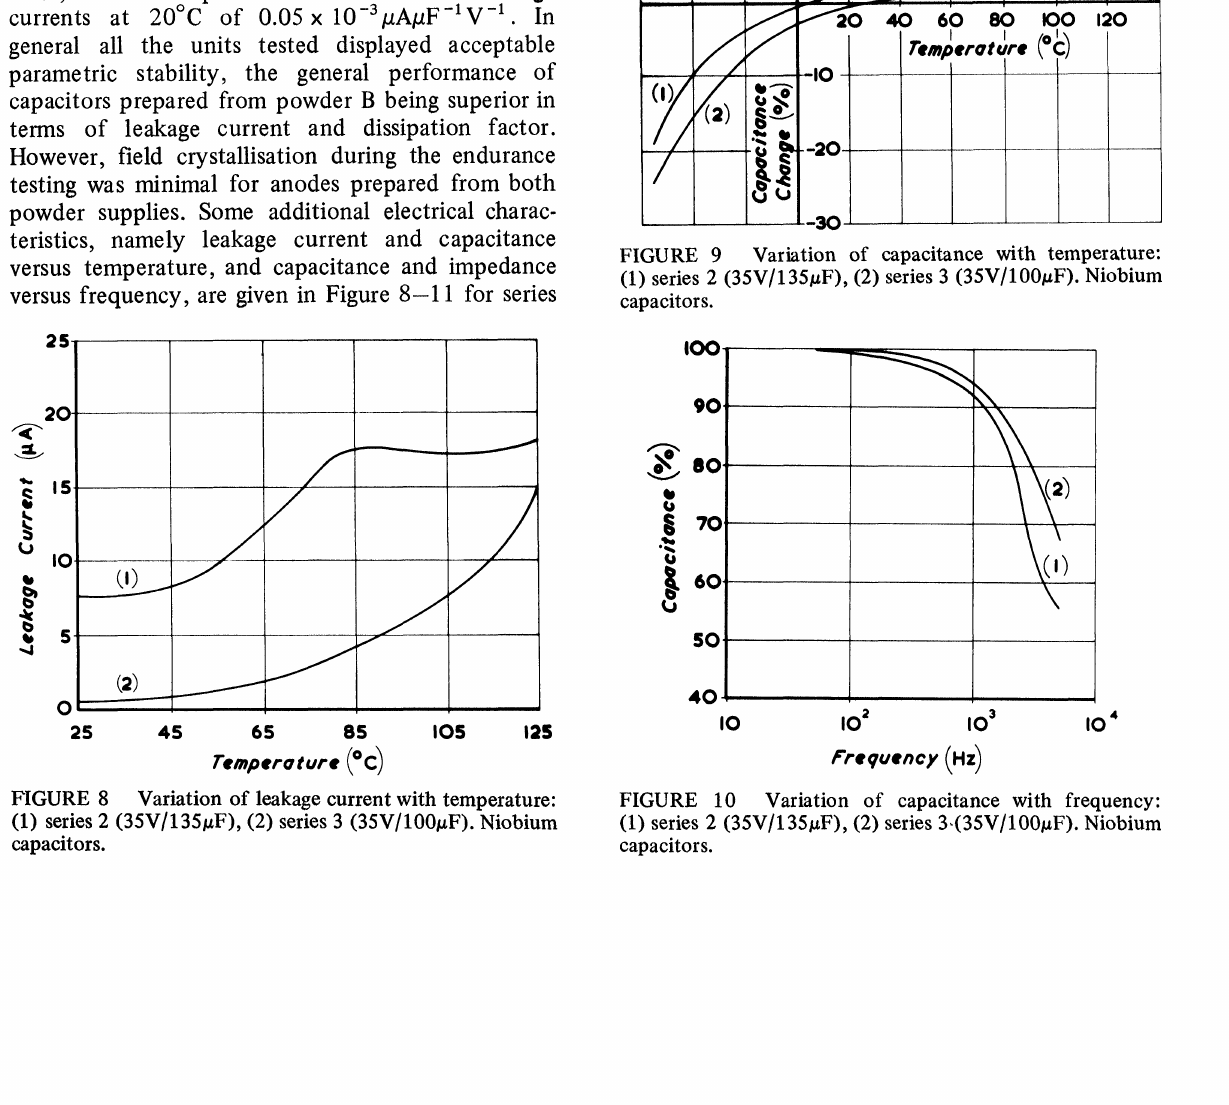
I0 I0 I0 ’ Frequency (Hz) Variation of capacitance with frequency: (1) series 2 (35V/135#F), (2) series 3-(35V/100#F). Niobium